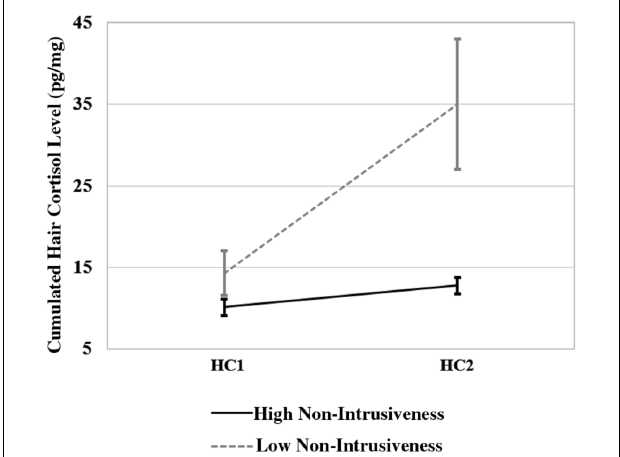
FIGURE 2 | Interaction between “change in cortisol level” (HC1 vs. HC2) and “non-intrusiveness” (high vs. low non-intrusiveness).